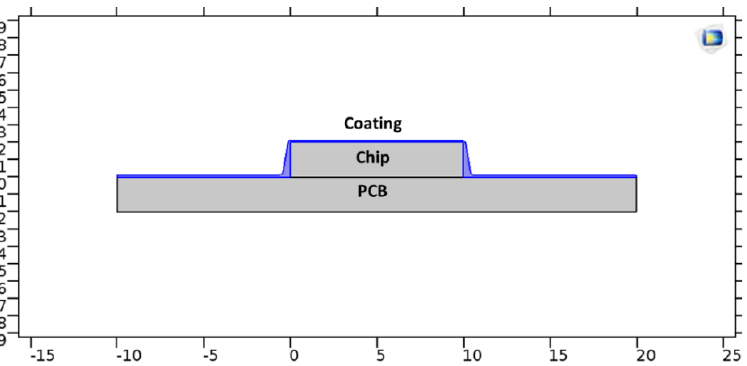
Figure 14. Geometry of 2D FEA modeling of chip attached to PCB; x, y units are in mm. Because of the presence of the chip, new zones of high stress are expected at the junction between the PCB and the chip or the upper left and right corners of the chip.